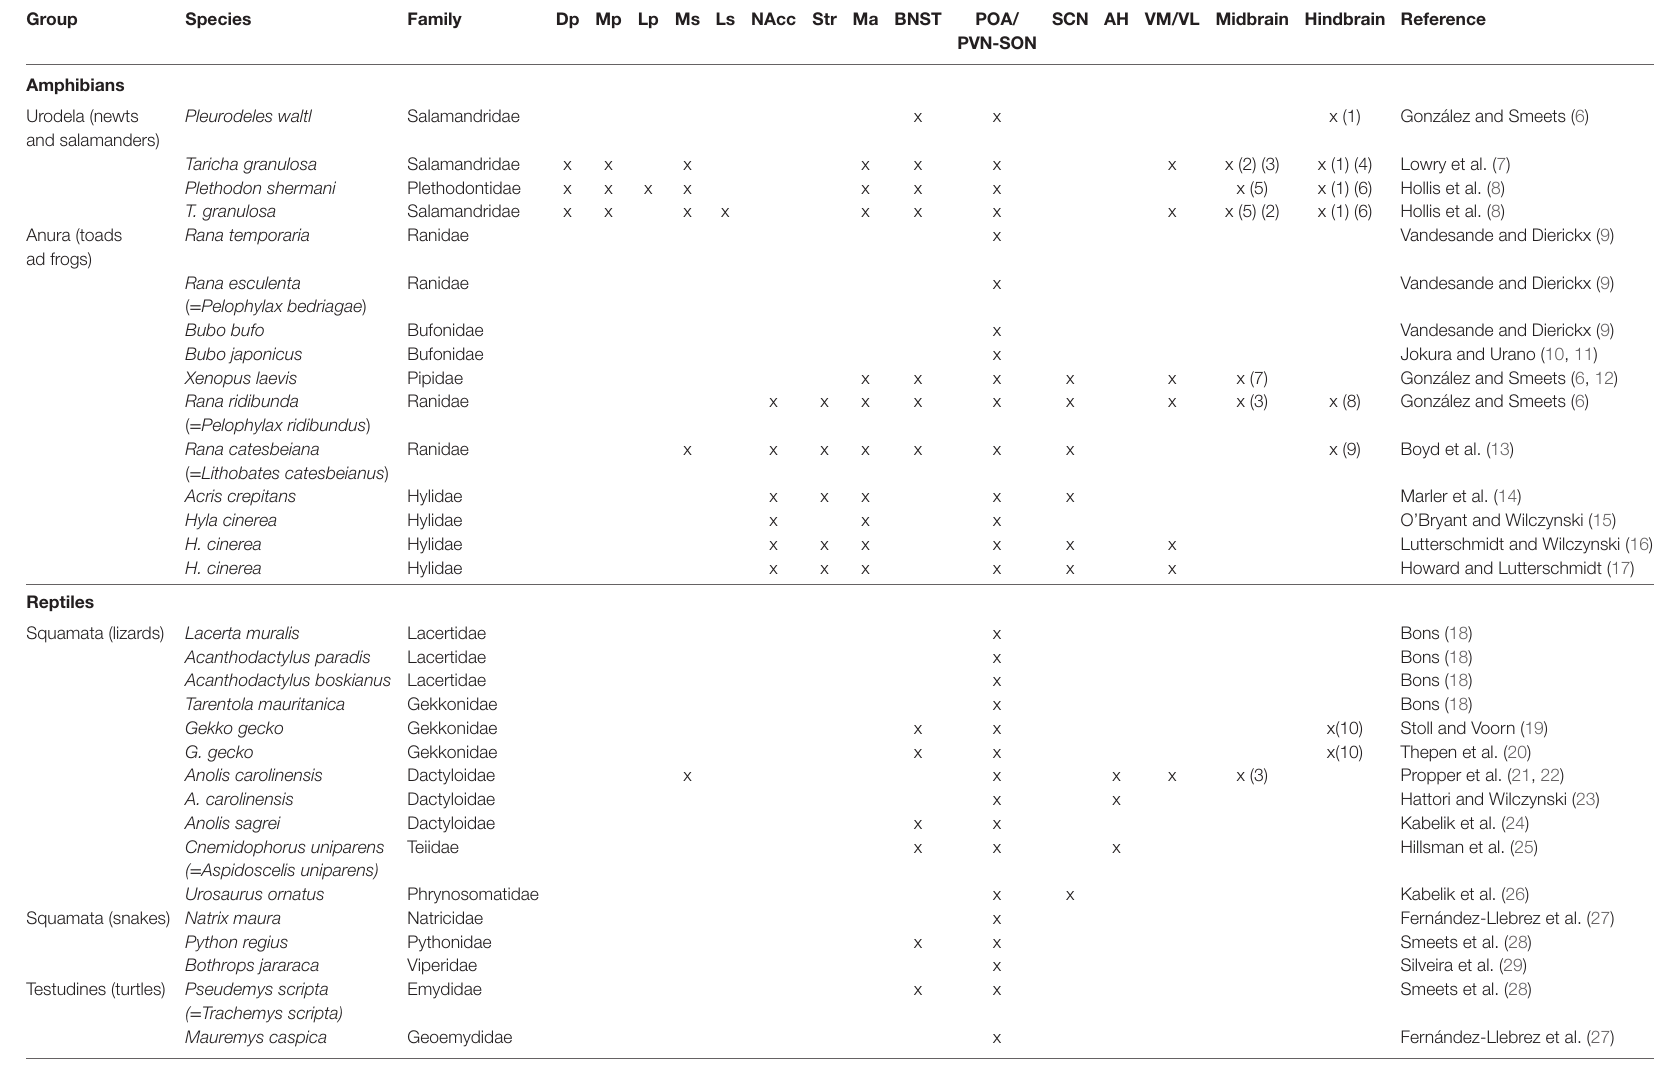
TABLe 1 | Brain regions containing arginine vasotocin (AVT) cells in different amphibian and reptile species.